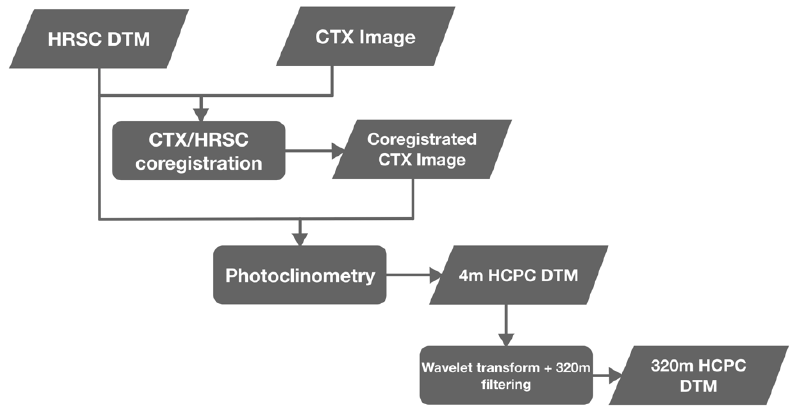
Figure 12. Data-processing flowchart for photoclinometry using the HRSC DTM and the CTX image.